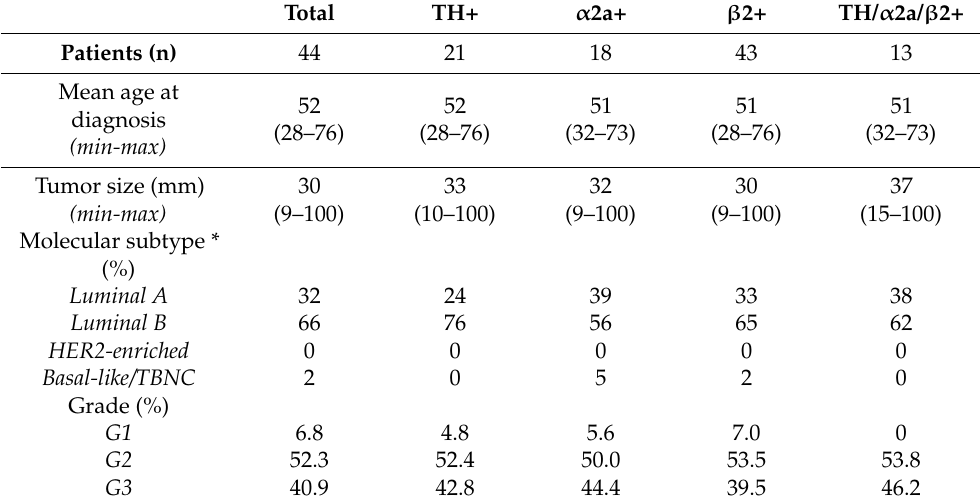
Table 2. Correlations between the clinicopathological data of the BC patients and the expression of a sympathetic innervation marker (TH) and adrenergic receptors ( α 2a and β 2) in bone metastasis biopsies retrieved from BC